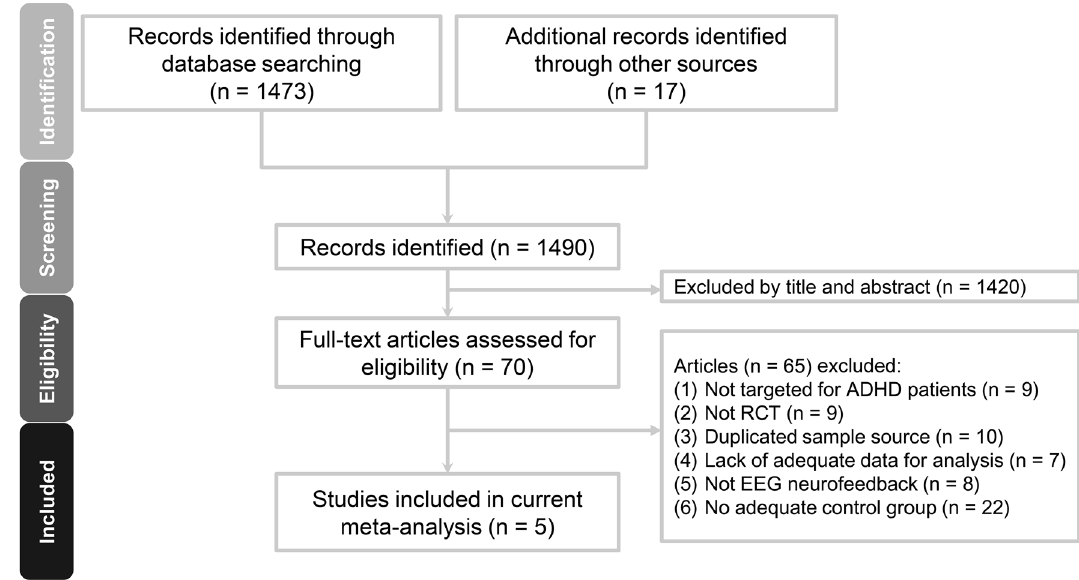
Figure 1. Meta-analysis flowchart for selecting eligible studies. RCT: randomized controlled trial; ADHD: attention-deficit hyperactivity disorder; EEG: